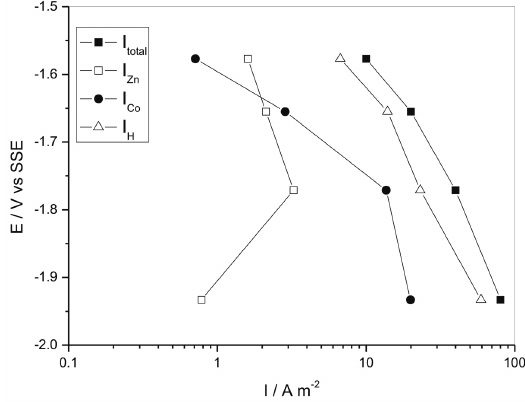
Figure 5. Partial current densities of each one of the deposited metals ( I , I ) and of the HER process ( I Zn Co